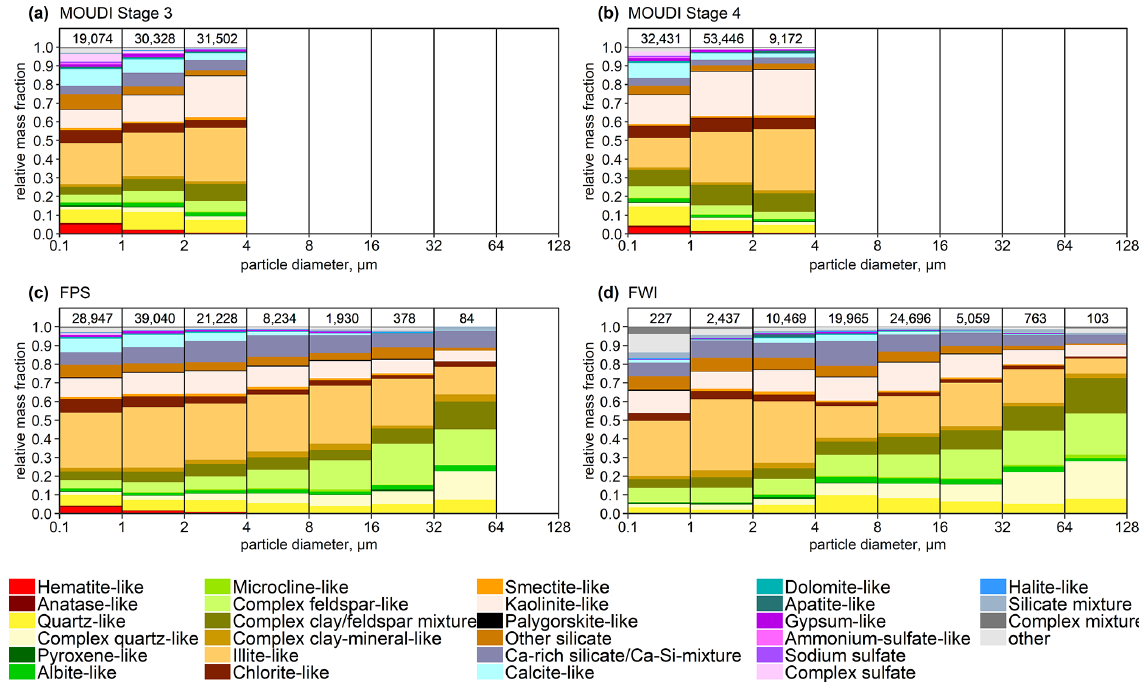
Figure 5. Average size-resolved mass abundance of different particle groups using different sampling techniques collected over the campaign period. The numbers on top represent total particle counts in the given size bin. Abundance bars are not shown for size bins with fewer than 30 particles.